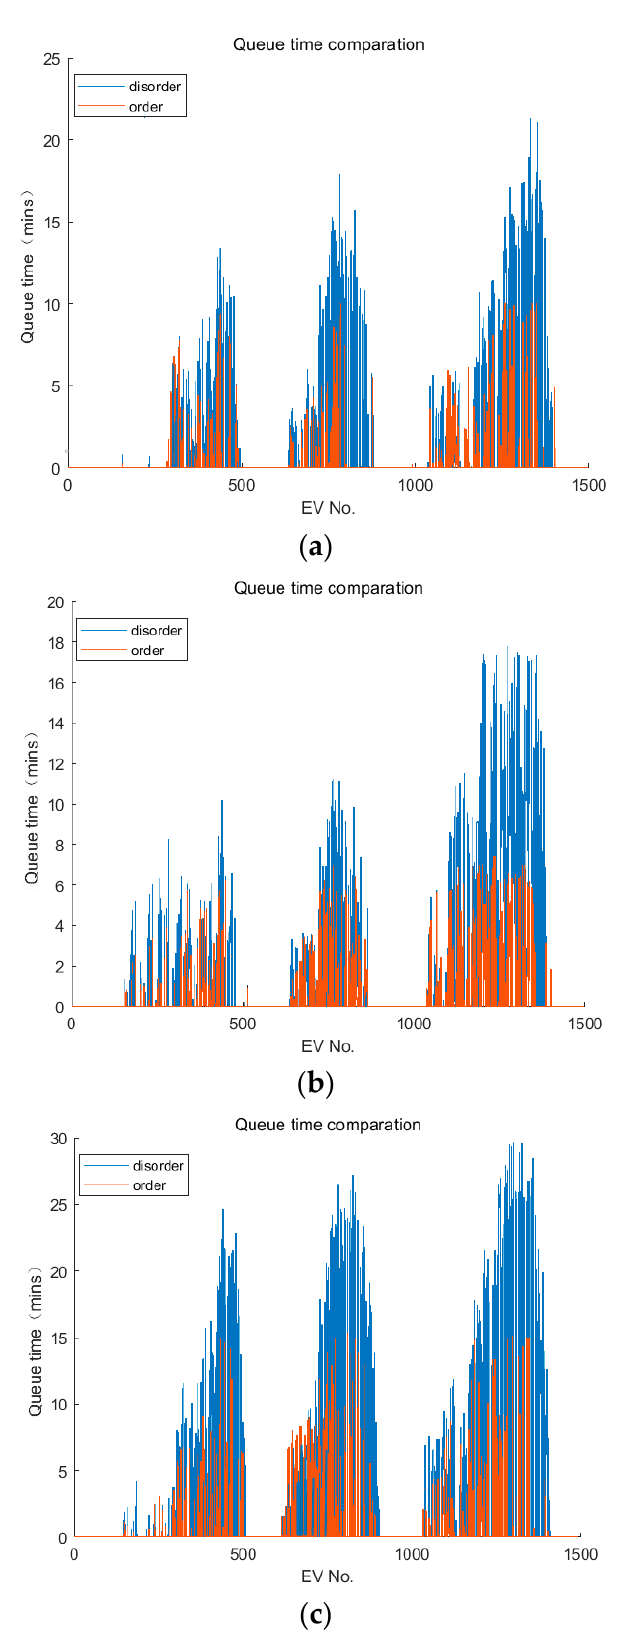
Figure 14. ( a ) Queue time comparison at 0 °C. ( b ) Queue time comparison at 25 °C. ( c ) Queue time comparison at − 20 °C. Table 2. Queueing conditions at different temperatures.